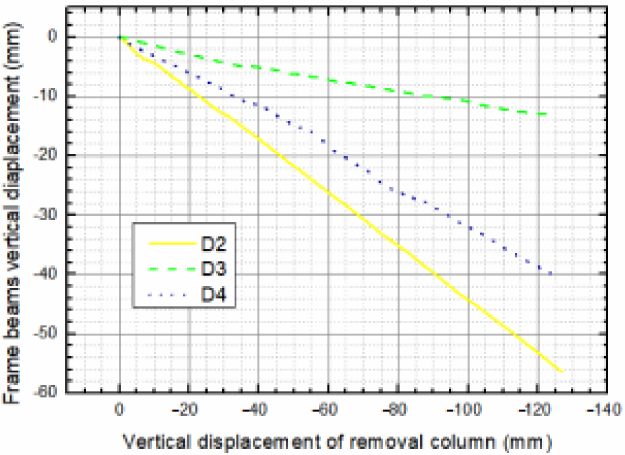
Figure 9. The vertical displacement of the DAP